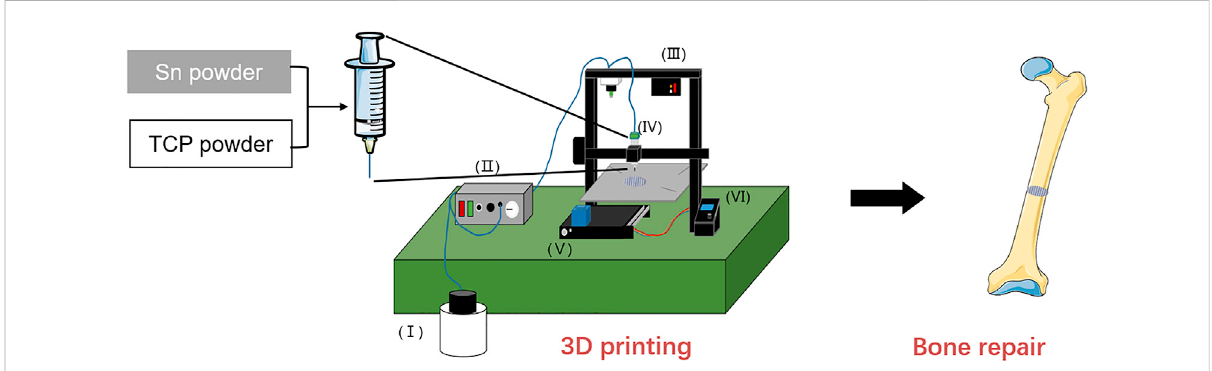
FIGURE 1 Schematic illustration of the preparation for Sn doping TCP scaffolds. Structure composition of 3D printer, Ⅰ : Compressor, Ⅱ : controller of compressor, Ⅲ : pressure alarm, Ⅳ : printhead, Ⅴ : z -axis screw, Ⅵ : controller of printing.